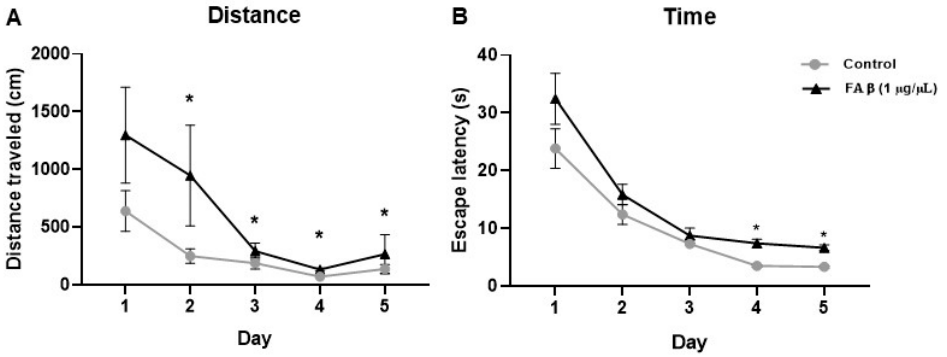
Figure 1. Effects of FA β 1-42 infusion on learning and memory capacity evaluated by the Morris Water Maze (MWM) test . The distance and the escape latency performed by rats ( n = 10) injected with FA β 1-42 at a concentration of 1 µg/µL was evaluated at day 14 post-injection. ( A ) Total distance traveled and ( B ) Total escape latency used by rats during the 5 days of training. Control group ( n = 10) of animals was injected with PBS. Data are represented as mean ± SEM. Statistical comparisons were performed using Kruskal–Wallis. * p ≤ 0.05.